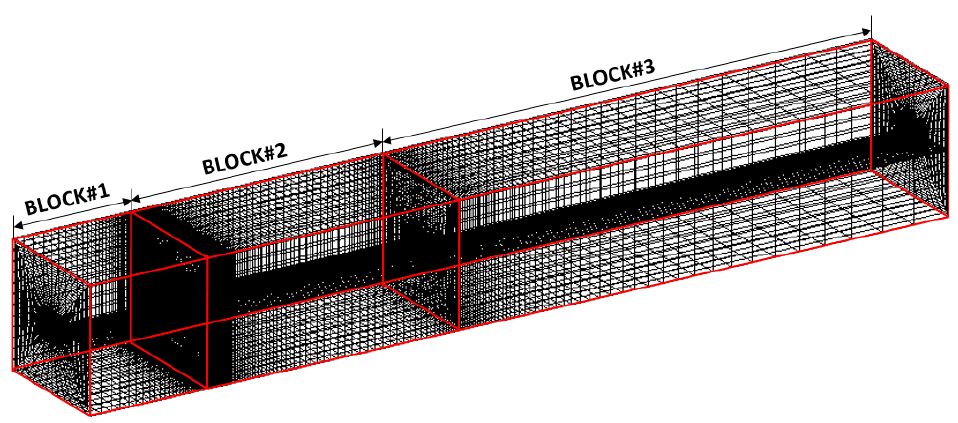
Figure 4. Computational grid for underwater vehicle.